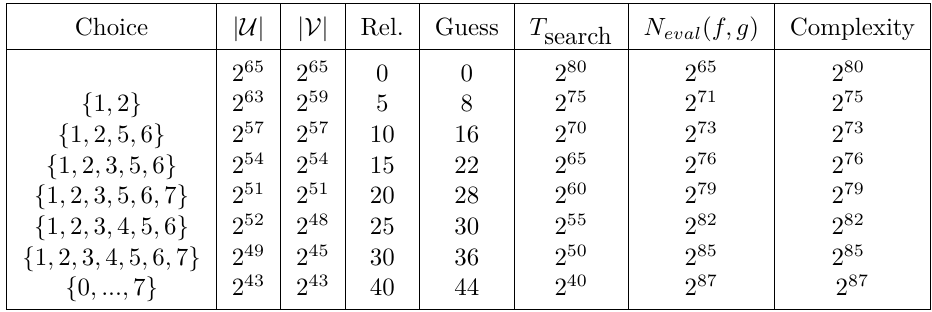
Table 2: Attack complexity for different choices of guessed slices. Guess is the number of bits the adversary has to guess and Rel. is the number of new sieving relations he gets. T search is the complexity of the exhaustive search on the remaining state values after the